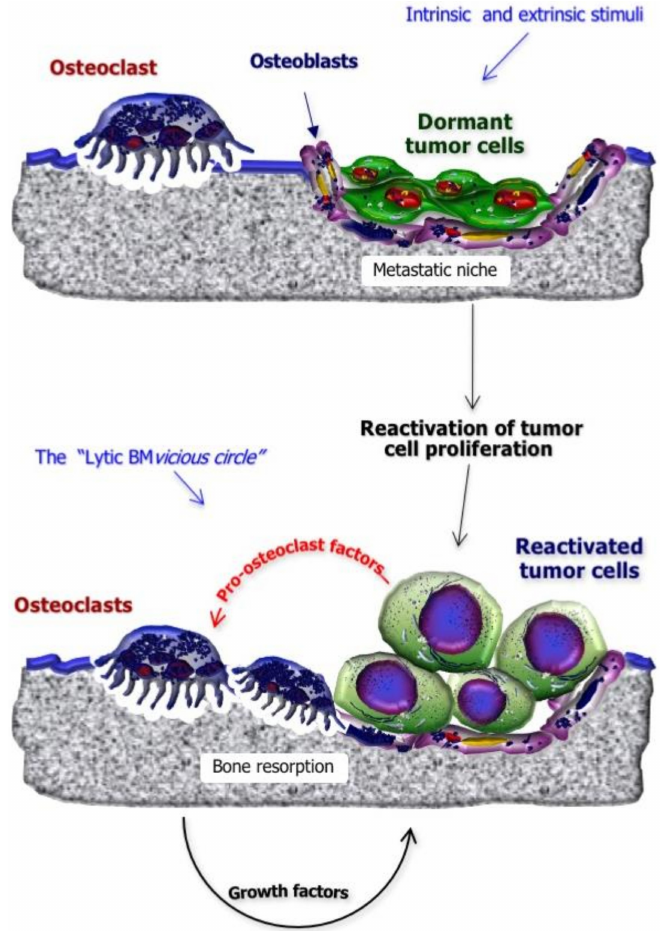
Figure 2. Reactivation of dormant BC cells and establishment of the “lytic BM vicious circle”. Once disseminated BC cells are settled in the premetastatic niche within the bone marrow, they enter a dormancy state that makes cells capable of escaping antitumor immune response and anticancer drugs. Such a dormant state may also last for years, and revitalization of dormant BC cells is dependent upon extrinsic and intrinsic stimuli, including soluble and inflammatory factors as well as genetic and epigenetic modifications. Once BC cells exit from dormancy, they undergo local expansion and secrete pro-osteoclastogenic cytokines to prime neighboring osteoclasts in their bone reabsorbing function, leading to a vicious circle where growth factors physiologically stored in bone are released and further accelerate BC cell